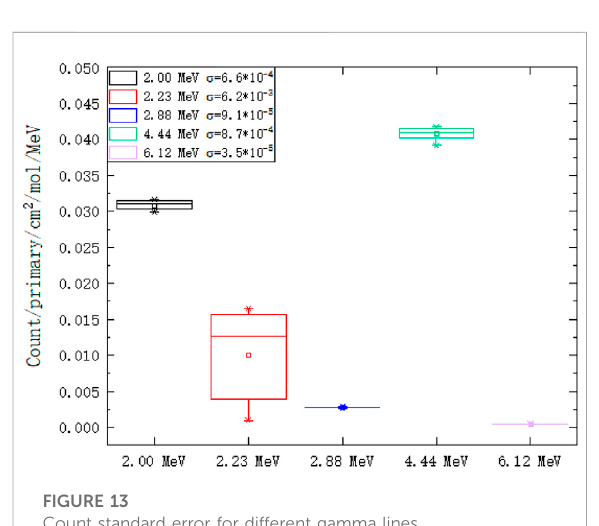
FIGURE 13 Count standard error for different gamma lines.